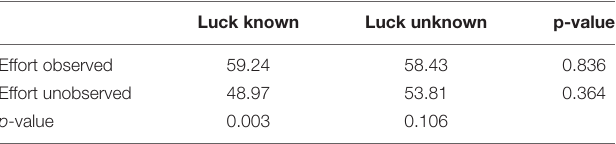
TABLE 5 | Comparison of effort